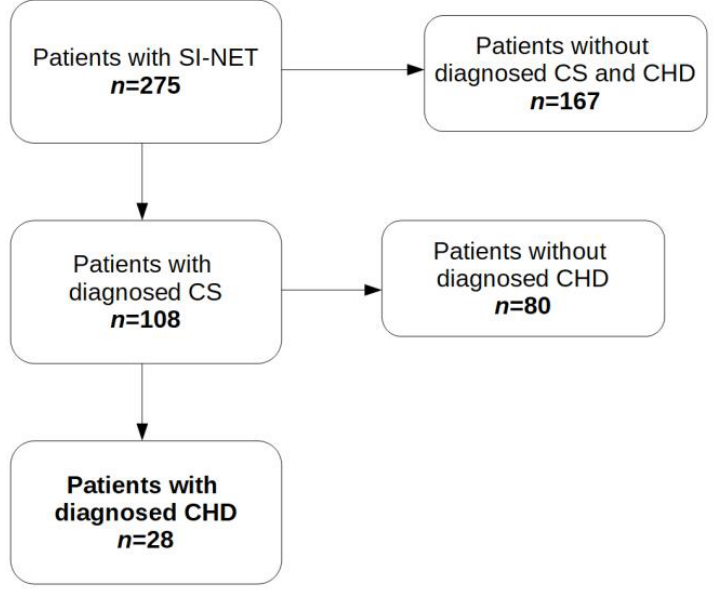
Figure 1. Patients enrolled in this retrospective study. Abbreviations: CHD, carcinoid heart disease; CS, carcinoid syndrome; SI-NET, neuroendocrine tumor of the small intestine. Twelve subjects with NET G1 (43%) and 16 with NET G2 (57%) in the course of CHD were analyzed. Table 2 provides a summary of the clinical and pathological data that were taken into account in this study. This analysis revealed that pT3 and pT4 tumors were most frequently seen in subjects with NET G2. Distant metastasis (M) and clinical stage IV were noted in 96% of patients with